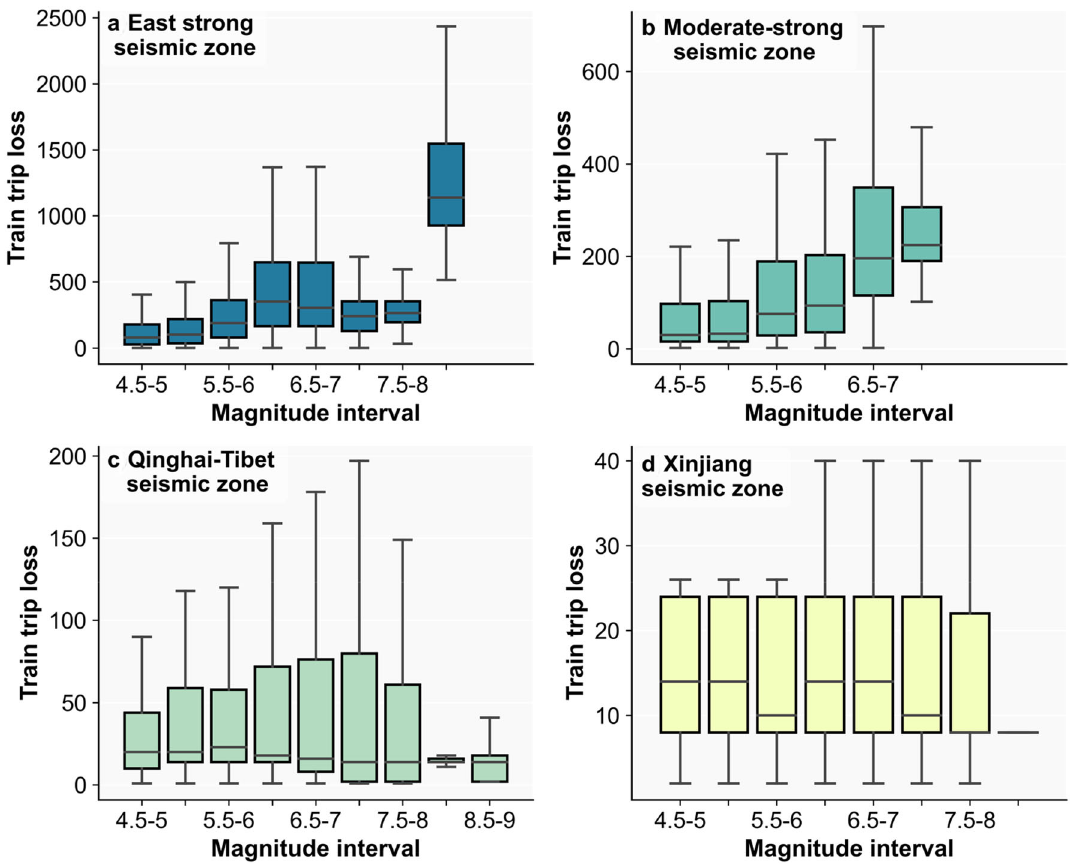
Fig. 7 Seismic impact on train services in different seismic zones: a East strong seismic zone; b moderate-strong seismic zone; c Qinghai-Tibet seismic zone; and d Xinjiang seismic zone. The